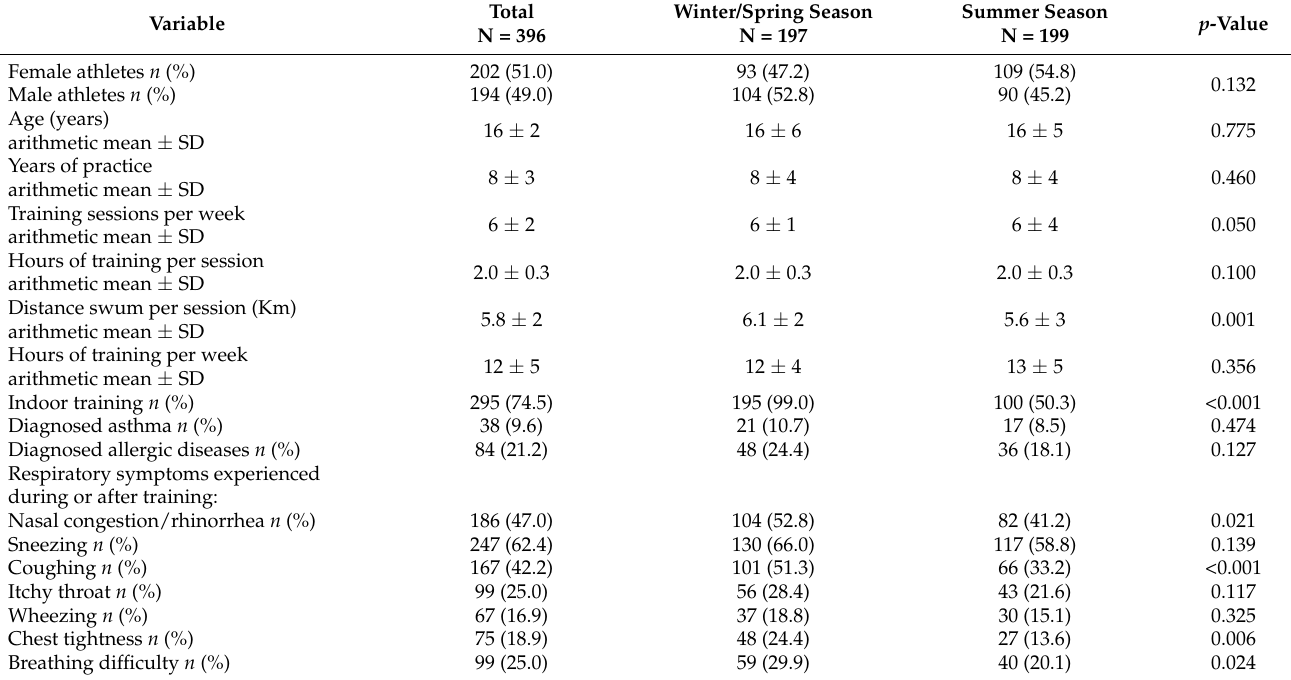
Table 1. Main characteristics of the study population and results of descriptive analysis, considering all the participants and the subgroups according to the